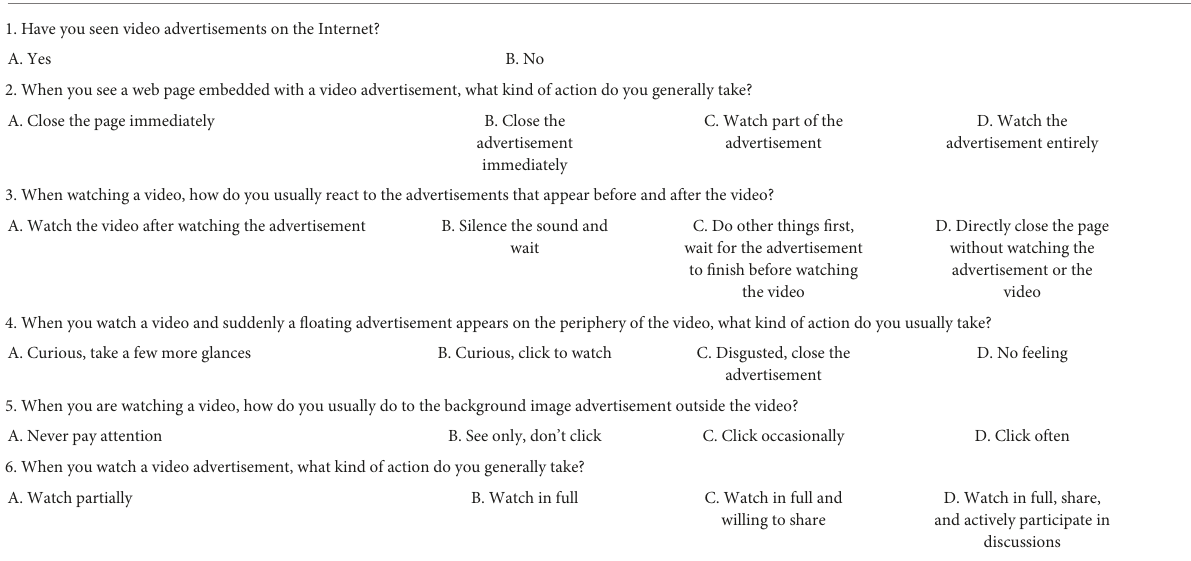
TABLE 1 Questionnaire